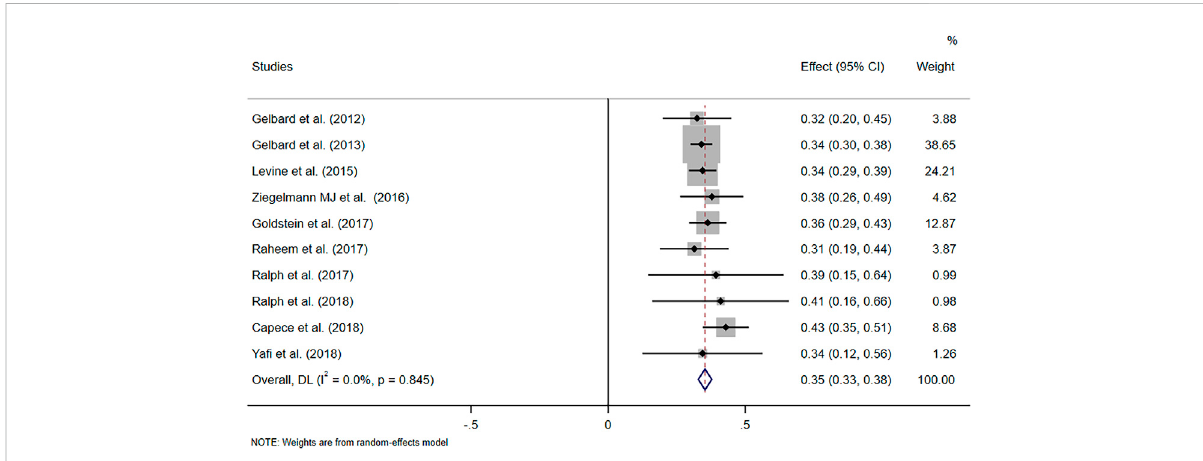
FIGURE 2 Forest plot of the pooled percentage of improved